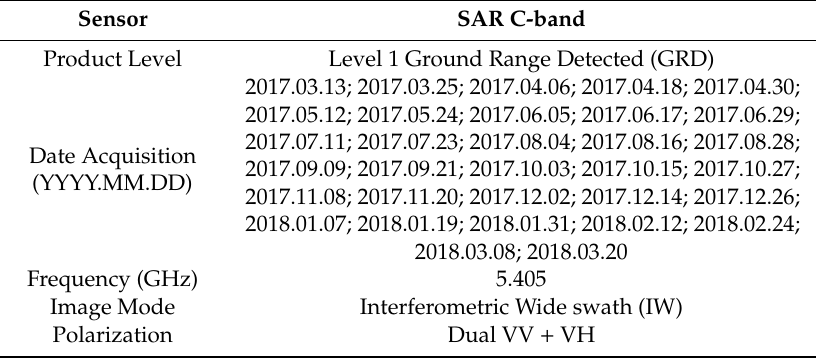
Table 1. Multitemporal Sentinel-1A data with specification and date of